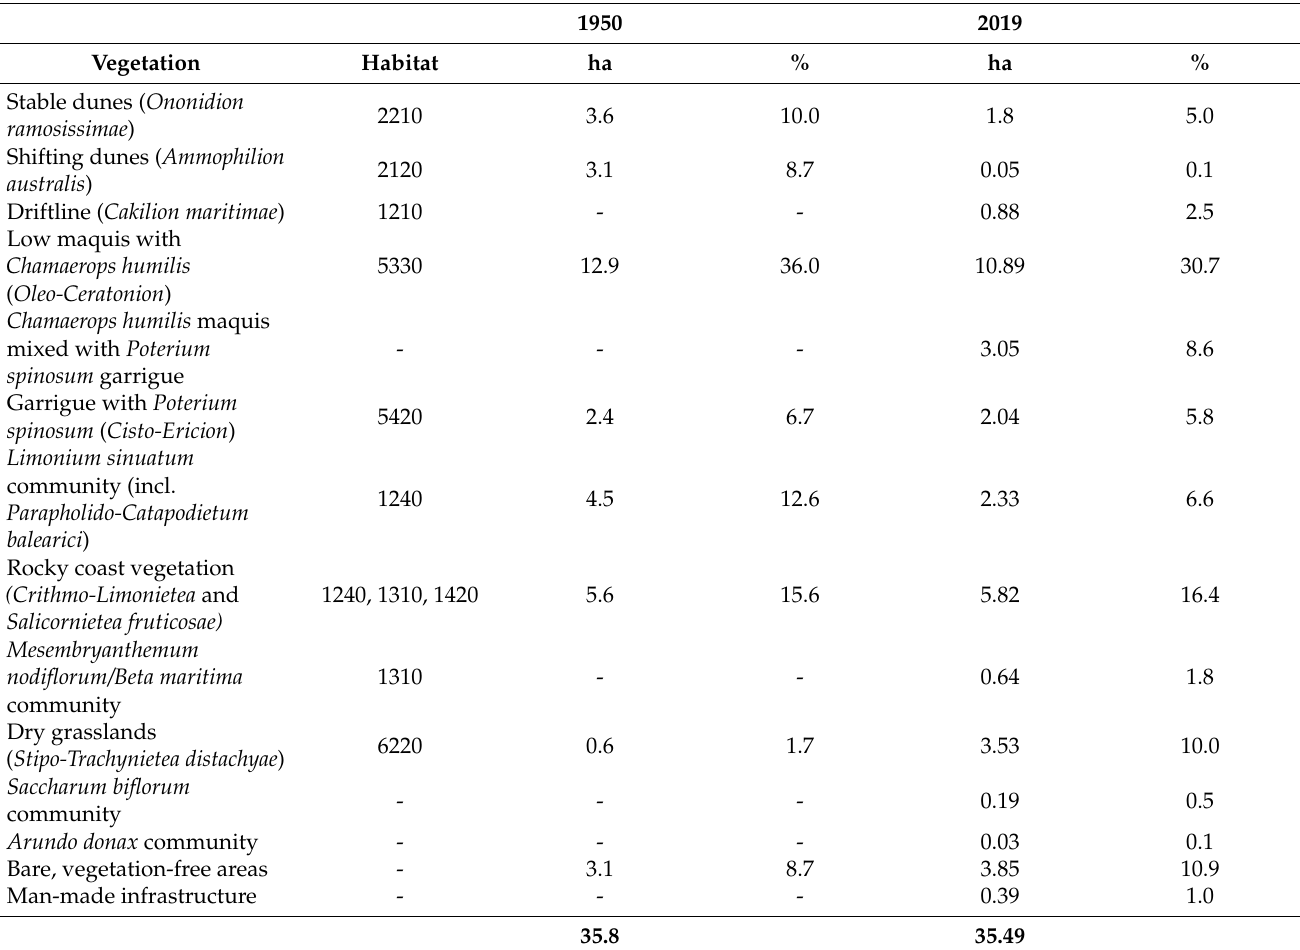
Table 1. Comparison of the surface covered by the different vegetation units/habitats based on the vegetation map of Pirola [34] and authors’ recent vegetation map